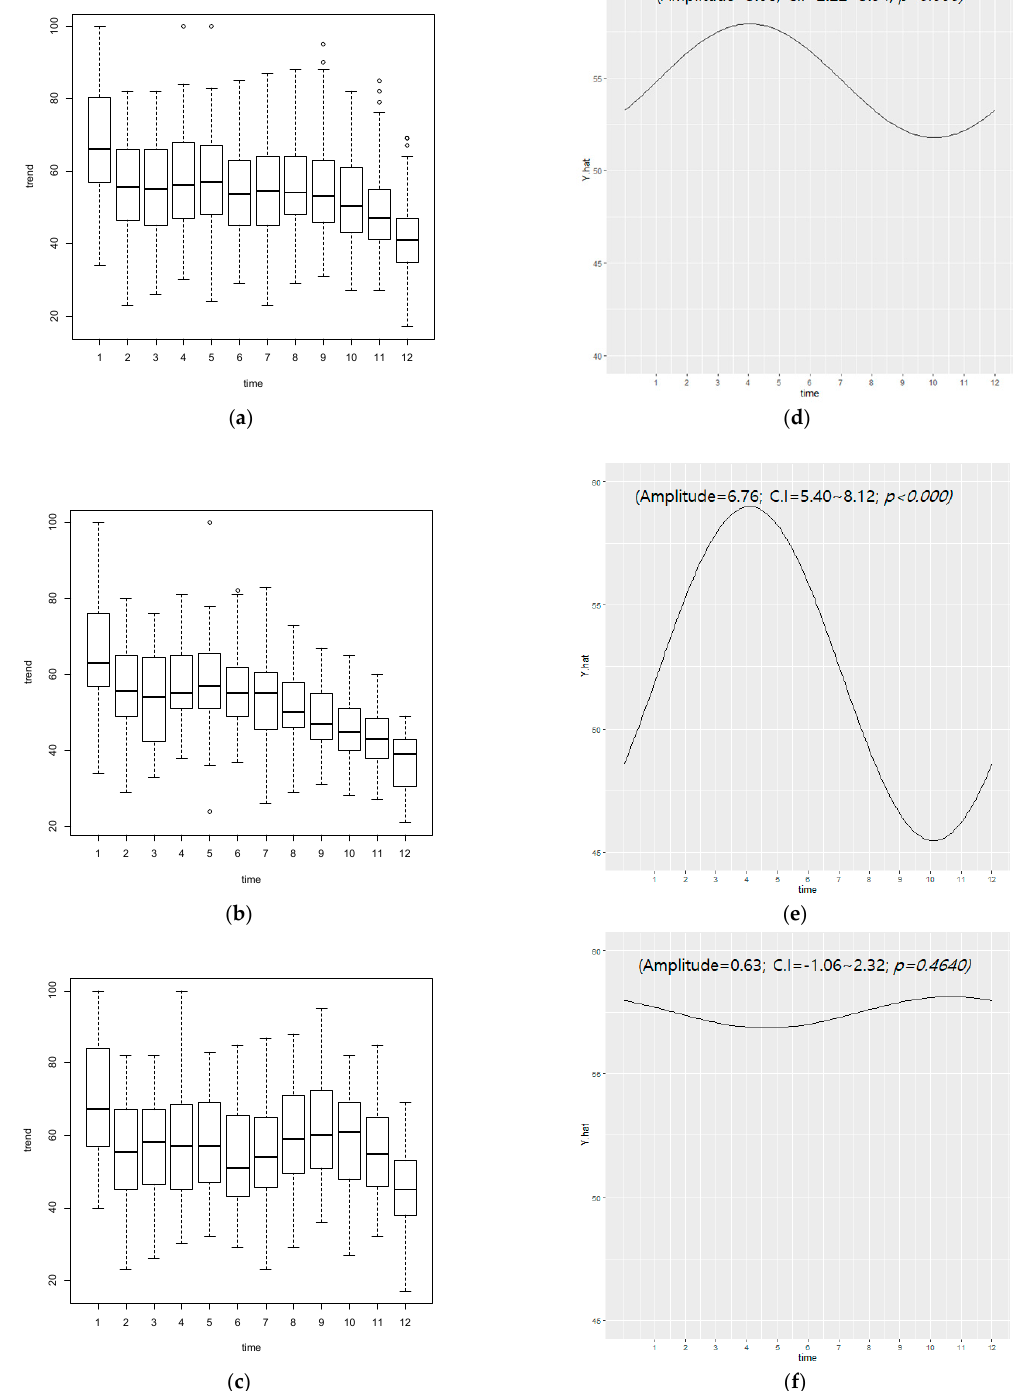
Figure 1. Monthly search volume and cycle for diet in Northern-Southern Hampshire. Search volume of ( a ) six countries with highest search volume, ( b ) three Northern, and ( c ) three Southern countries. Cycle by cosinor analysis of ( d ) six countries with highest search volume, ( e ) three Northern, and ( f ) three Southern countries. CI: 95% confidence interval; Unit of time is 1 month.; p -value < 0.05 corresponds to the statistical significance of seasonal periodicity of diet interest in each group.